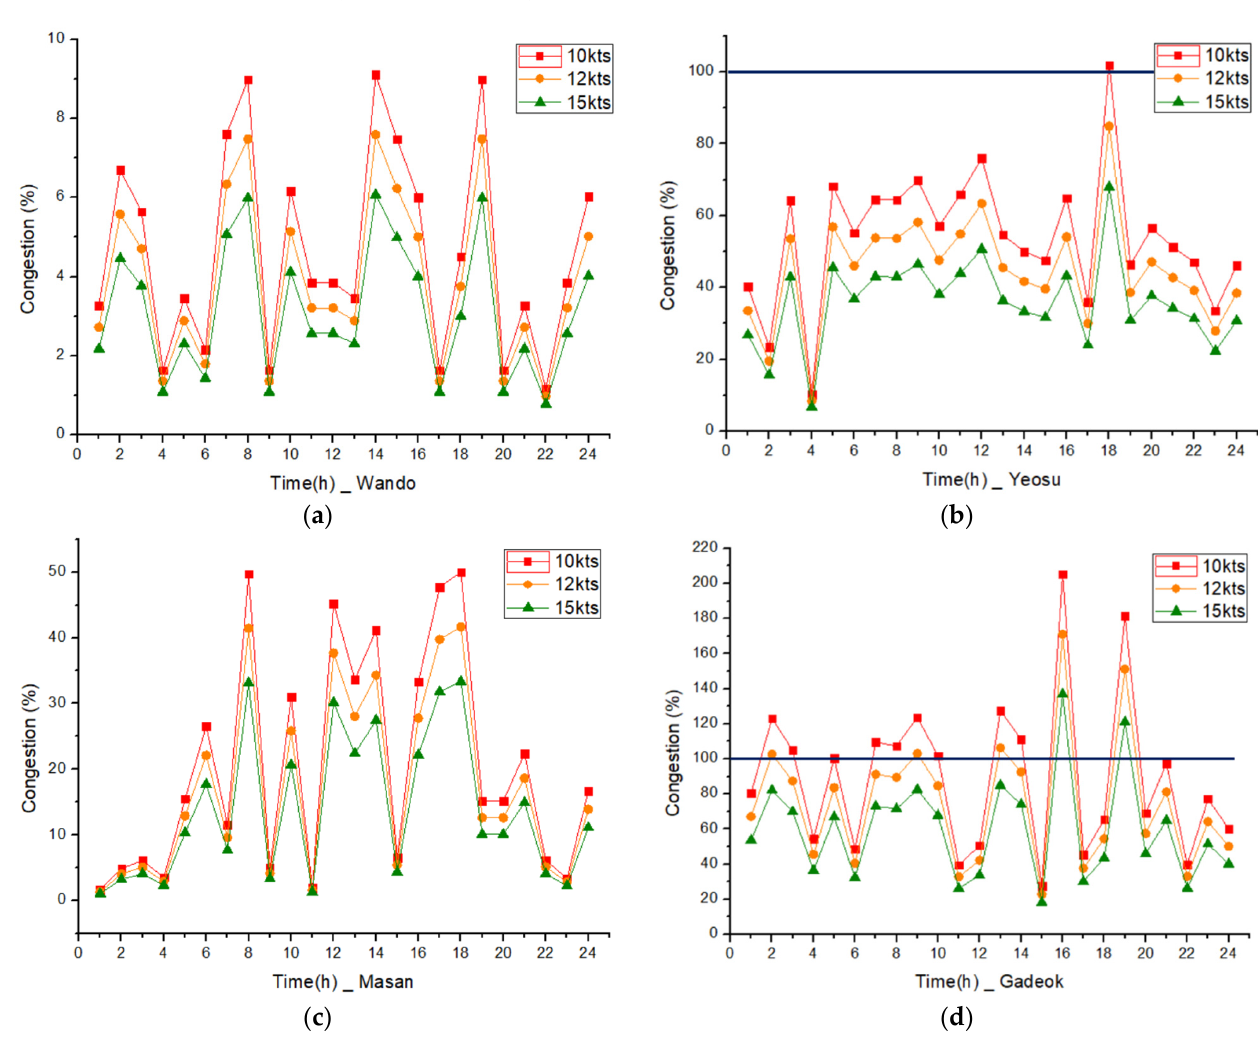
Figure 6. ( a ) Hourly congestion evaluation result of the Wando fairway, ( b ) the Yeosu fairway, ( c ) the Masan fairway, and ( d ) the Gadeok fairway. Masan fairway, and ( d ) the Gadeok